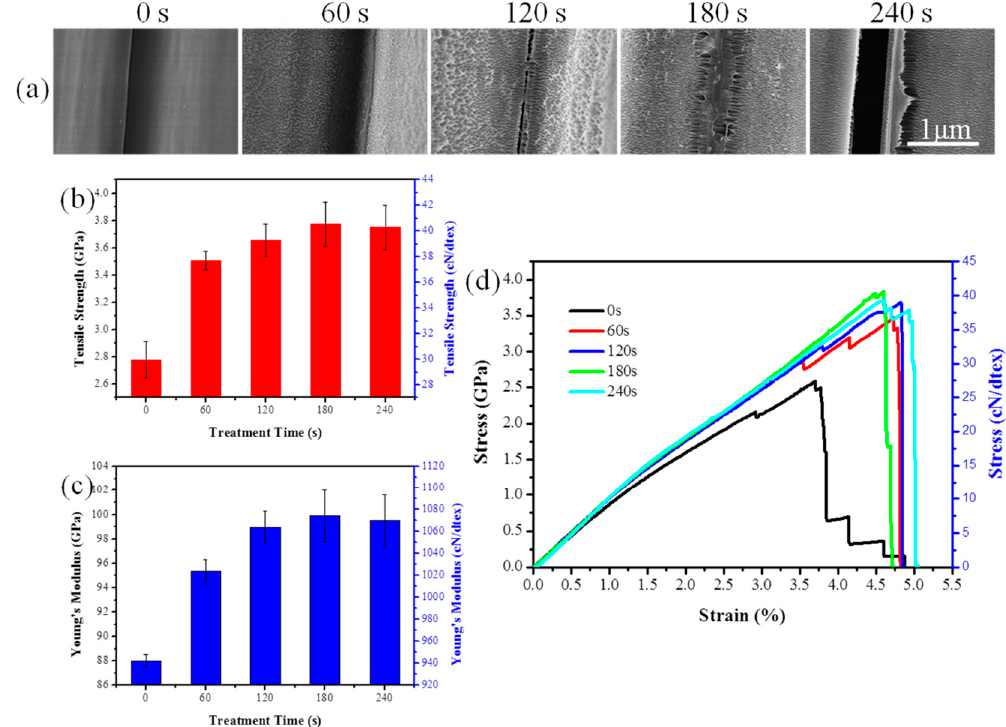
Figure 6. ( a ) Morphologies of the contact area between single PI filament, ( b ) tensile strength, ( c ) tensile modulus and ( d ) stress–strain curves of pristine and plasma treated PI filaments.